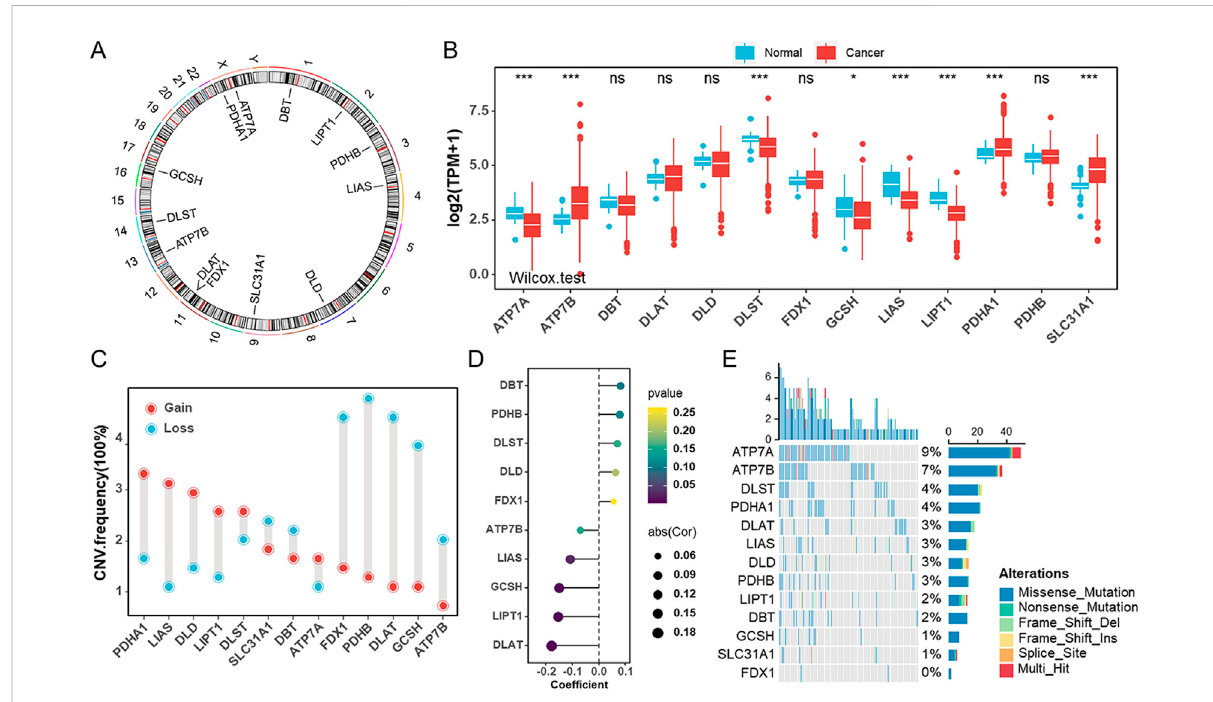
FIGURE 1 Genetic and transcriptional alterations of cuproptosis genes in endometrial cancer (A) . The locations of cuproptosis genes on chromosomes. (B) ThemRNAlevelsof13cuproptosisgeneswerecomparedbetweennormalandtumortissuesinTCGA-UCECcohort. (C) TheCNVfrequenciesof 13cuproptosisgenesinTCGA-UCECcohort. (D) Thebubblechartrevealingthecorrelationbetweenthepromotermethylationlevelsofcuproptosis genes and their mRNA levels in TCGA-UCEC cohort. (E) The mutation frequencies of 13 cuproptosis genes in TCGA-UCEC